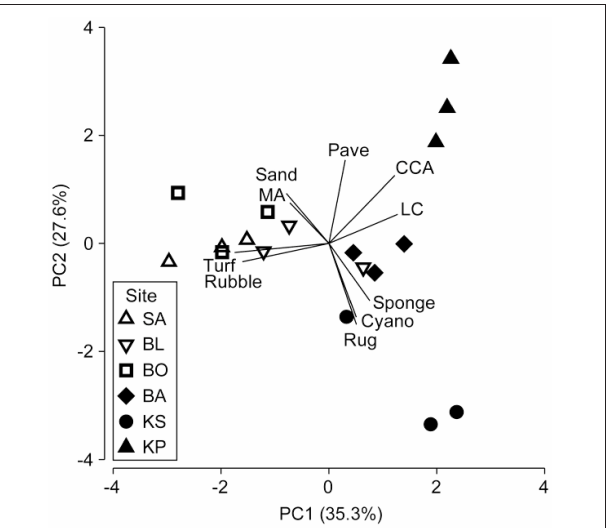
FIGURE 2 | Principal component analysis (PCA) performed on benthic biota, structure and rugosity [macroalgae (MA), crustose coralline algae (CCA), sponge, cyanobacteria (Cyano), live coral (LC), turf algae (Turf), sand, pavement (Pave), rubble and rugosity (Rug); Table 1 ]. The three sites nearest to shore a (SA, Samalona 7km; BL, Barrang Lompo 11km; BO, Bonetambung 14km) are indicated with open symbols. The three sites further from shore (BA, Badi 19m; KS, Karang Kassi 27km; KP, Kapoposang 55km) are indicated with closed symbols. Vectors indicate direction of separation based on specific benthic